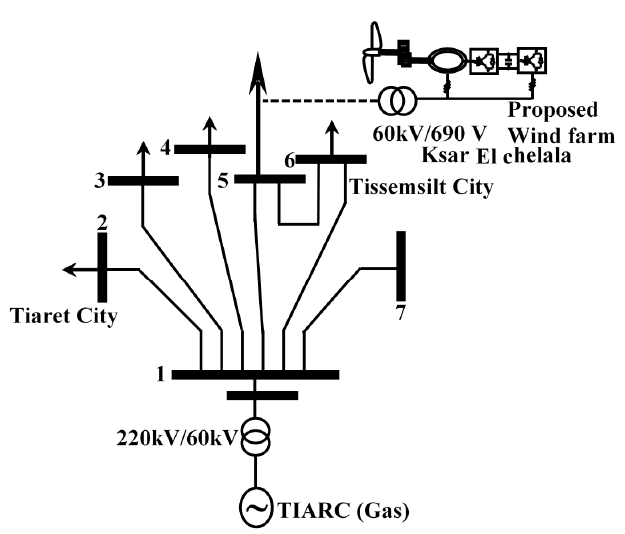
Figure 6. Western electrical grid near to the proposed wind farm.